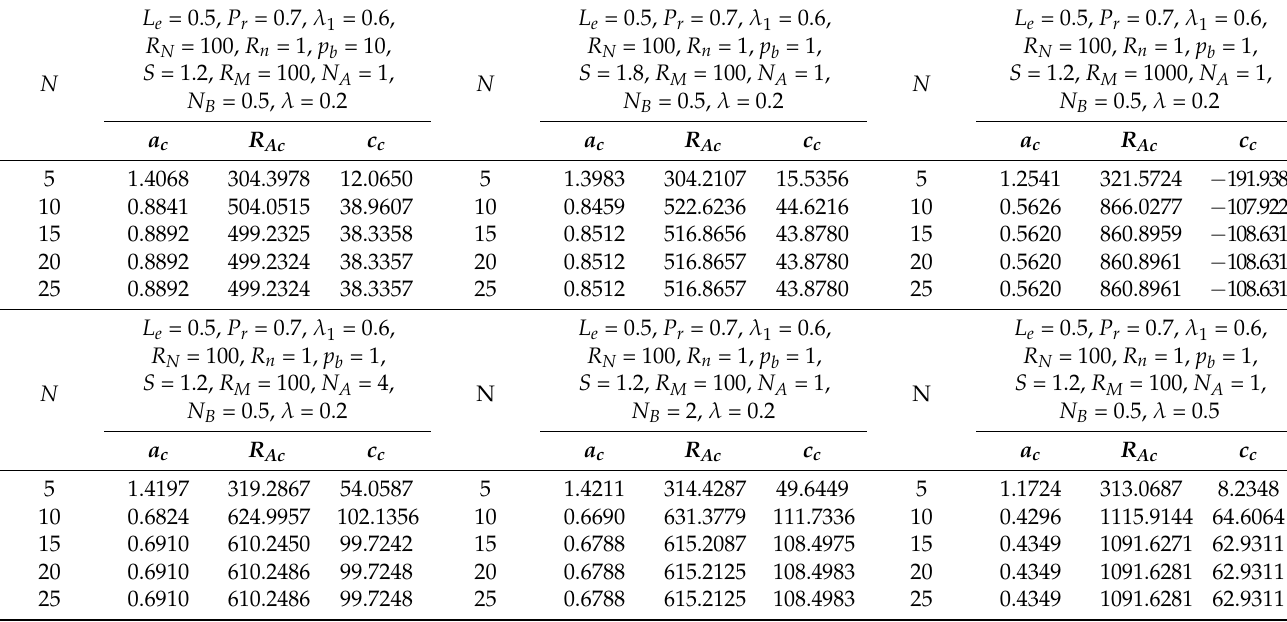
(Figure 3f), chemical reaction parameter S (Figure 3g), basic density Rayleigh number R M (Figure 3h), modified diffusivity ratio N A (Figure 3i), modified particle density